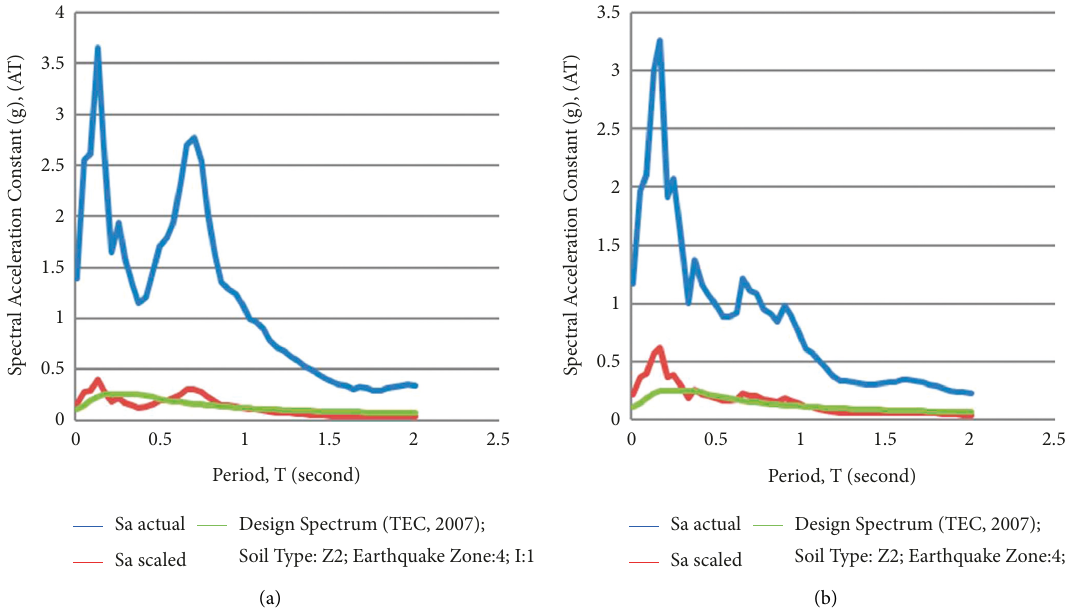
Figure 21: Evaluation of A(T) spectral acceleration constants at Nigde station for (a) North-South (N-S) and (b) East-West (E-W) components of earthquake with epicenter at Nigde-Camardi ( M L :